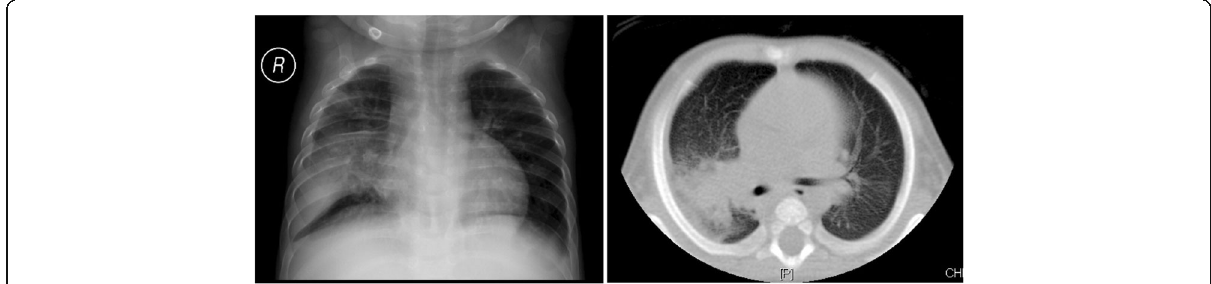
Fig. 2 Chest radiograph and computed tomography scan of the patient at the age of 3 months, which revealed pneumonic infiltration and consolidation of the middle and lower lobes of the right